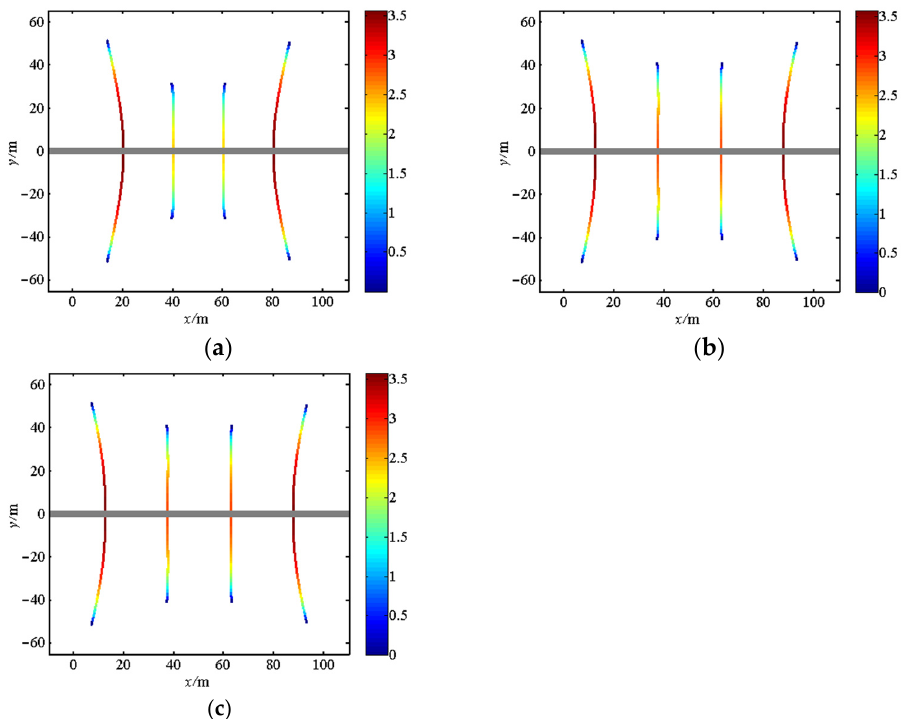
Figure 6. Fracture propagation path and fracture width distribution (mm) with different cluster spacings: ( a ) 20 m; ( b ) 25 m; ( c ) 30 m.